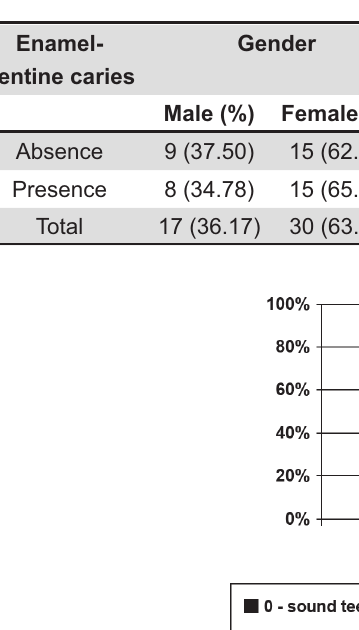
Figure 7- Distribution of Weerheijm, Gruythuysen and Van Amerongen 19 (1992) radiographic criteria on the different tooth groups (M= molar; PM= premolar)